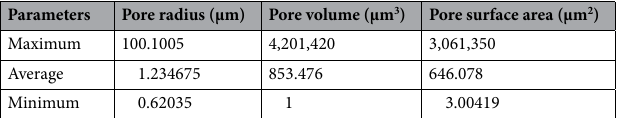
Table 3. Quantitative parameter statistics of pore model in nylon material.